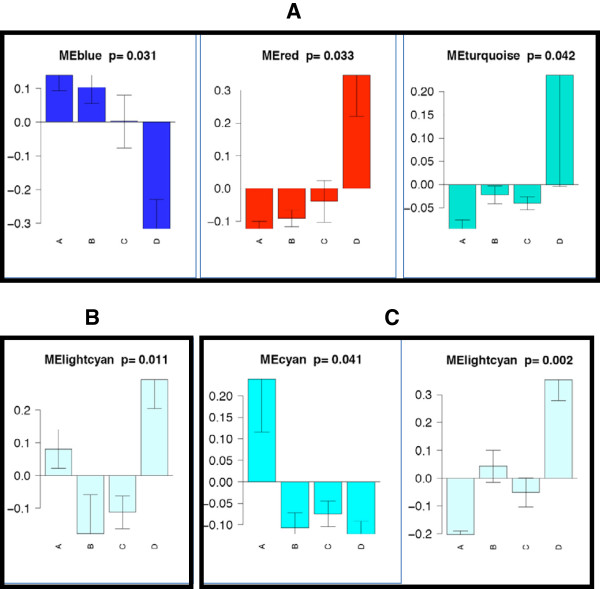
Modules show different expression patterns across groups. (A) The Blue, Red, and Turquoise modules from the frontal cortex show significant (Kruskal Wallis test p < 0.05) differences between groups. The Y axis corresponds to module eigengene expression. (B) The Light Cyan module shows increased expression with encephalitis in frontal white matter. In (C), the Cyan and Light Cyan modules show differential expression across groups in basal ganglia.